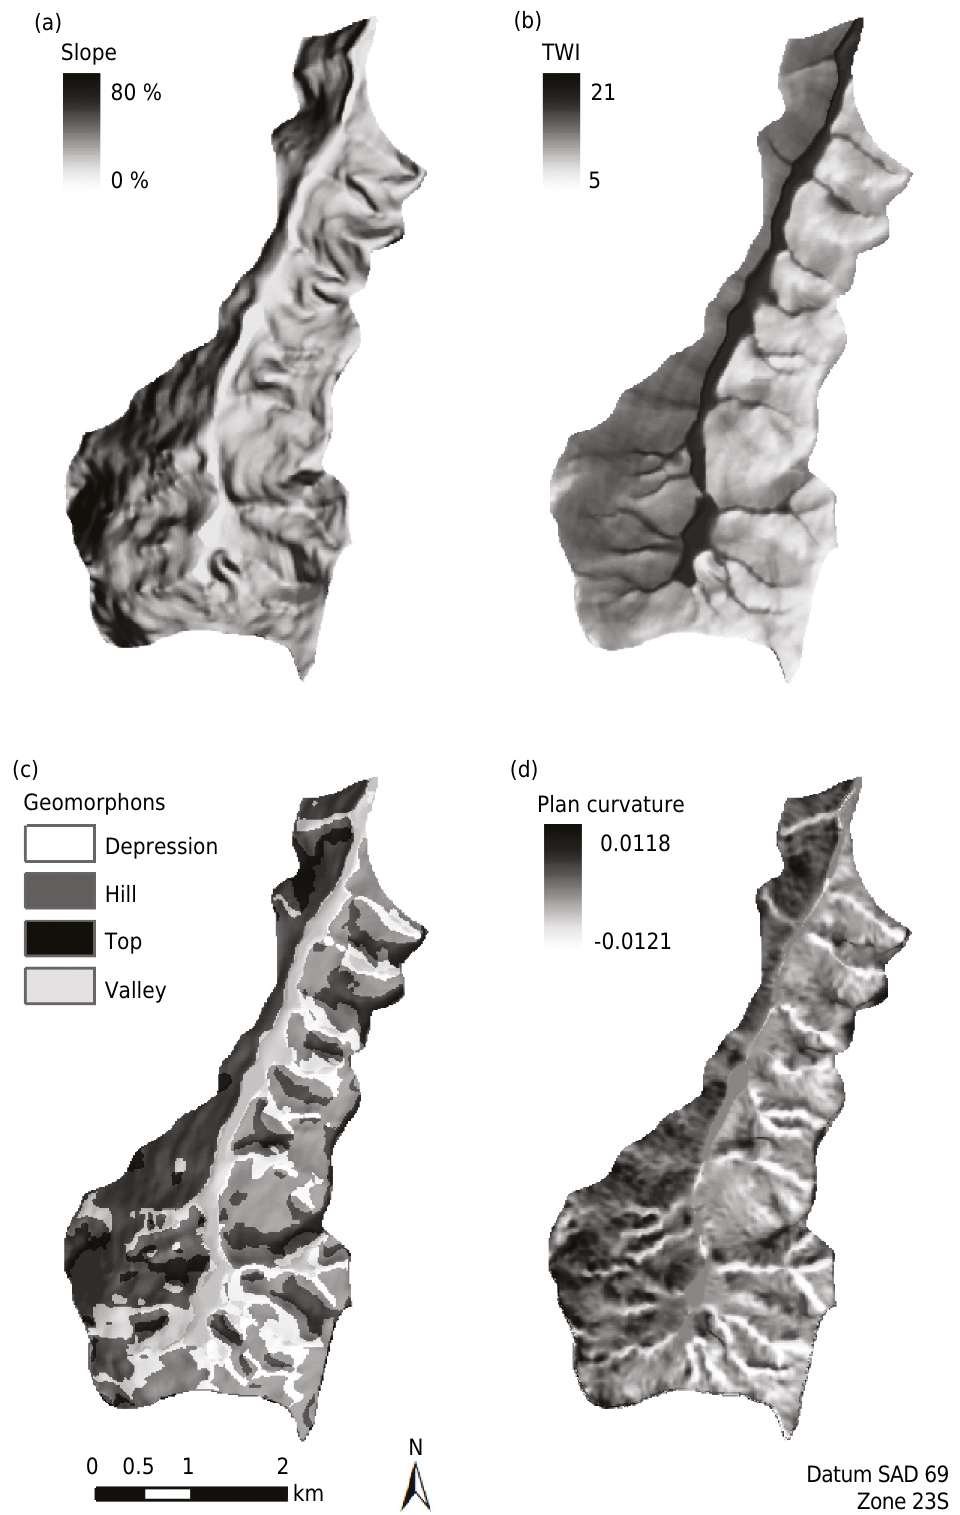
Figure 2. Terrain attributes slope (a), SAGA topographic wetness index (TWI) (b), geomorphons (c) and plan curvature (d) in the Posses watershed, Extrema,